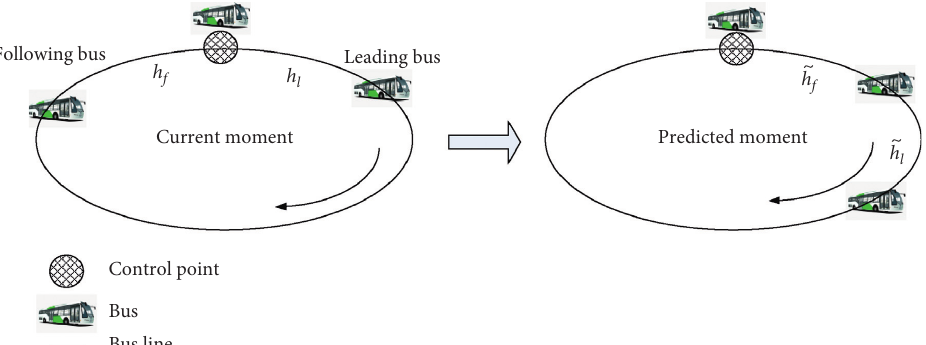
Figure 1: Prediction step length in the coordinated control method.